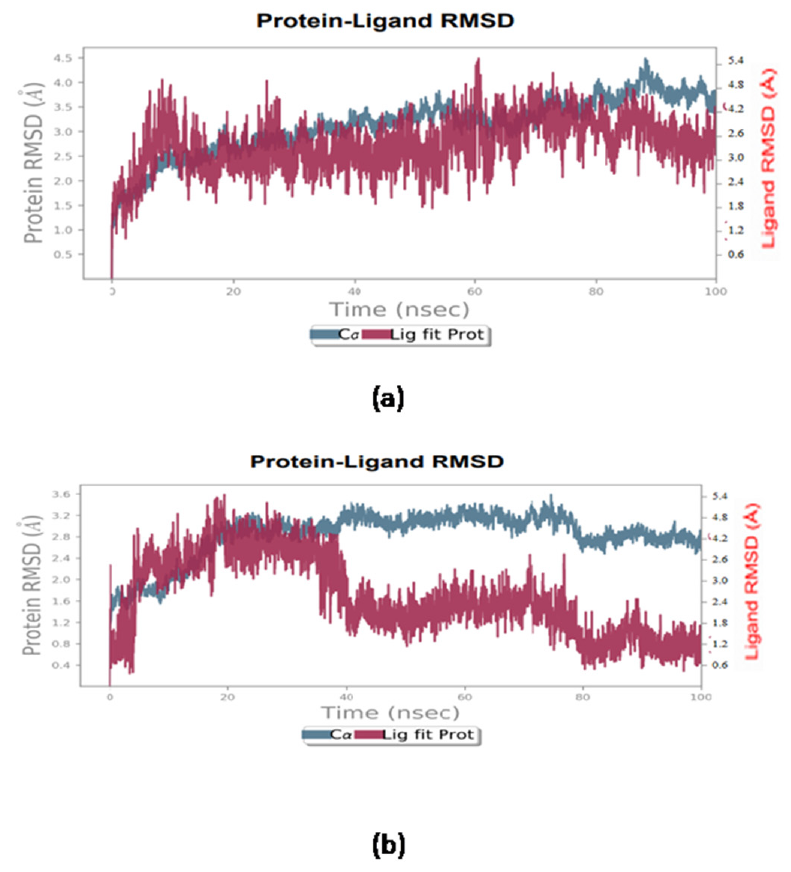
Figure 2. RMSD plot for the docked complex of ( a ) Gravacridonediol ‐ InhA ( b ) Triclosan ‐ InhA.